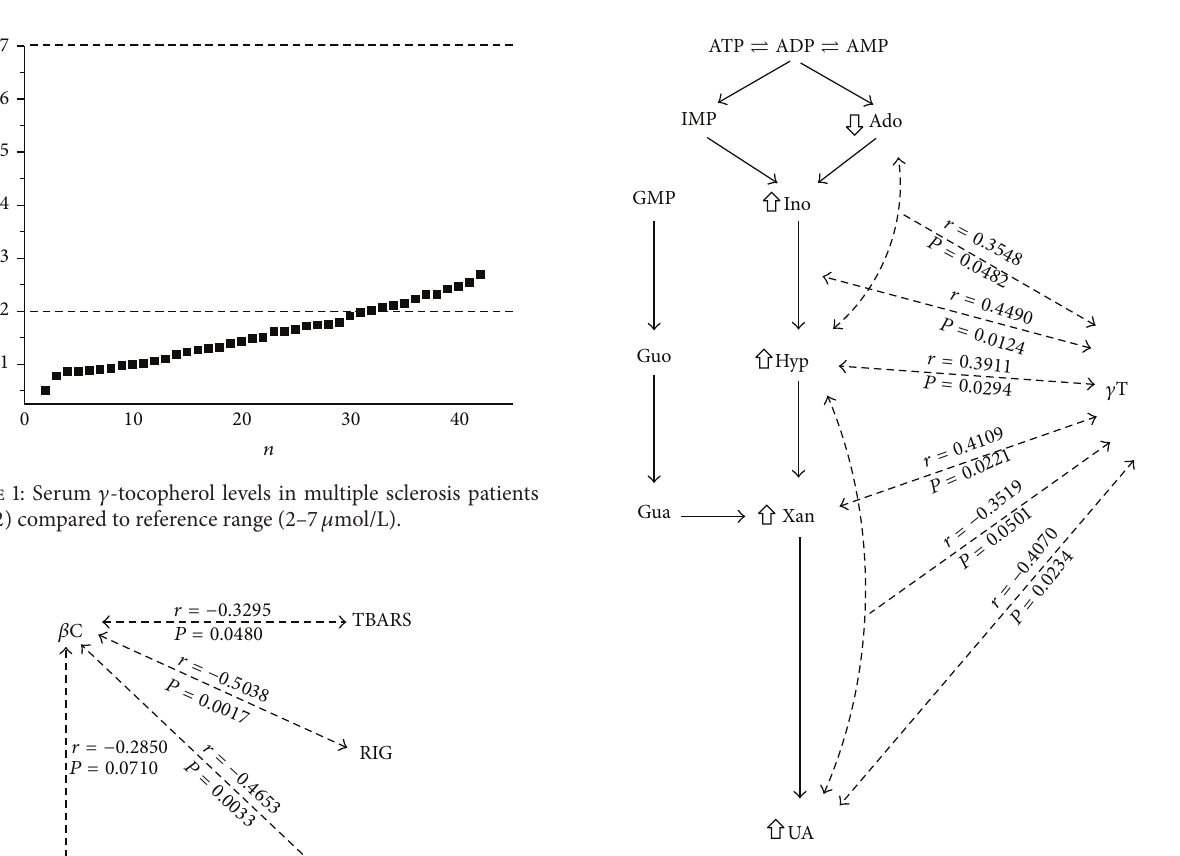
Figure 3: Spearman rank correlations between CSF purine nucleotide degradation products and serum 𝛾 -tocopherol in patients with multiple sclerosis. 𝛾 T: 𝛾 -tocopherol, Ado: adenosine, Ino: inosine, Hyp: hypoxanthine, Xan: xanthine, UA: uric acid, Guo: guanosine, and Gua: